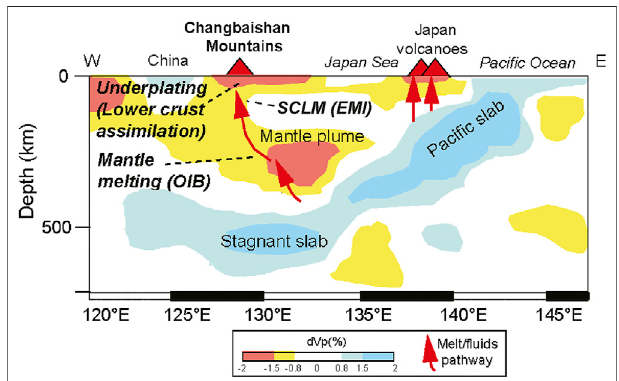
FIGURE 11 | Schematic model for the Pleistocene trachybasaltic volcanism of Changbaishan Mountains in NE China along a W-E striking section extending from NE China to Japan. Tomography (dVp%) is simpli fi ed from Ma et al. (2019). The depth of the OIB source, its EMI component, and the assimilation of crustal material are inferred for the large-scale structures evidenced from the tomography.